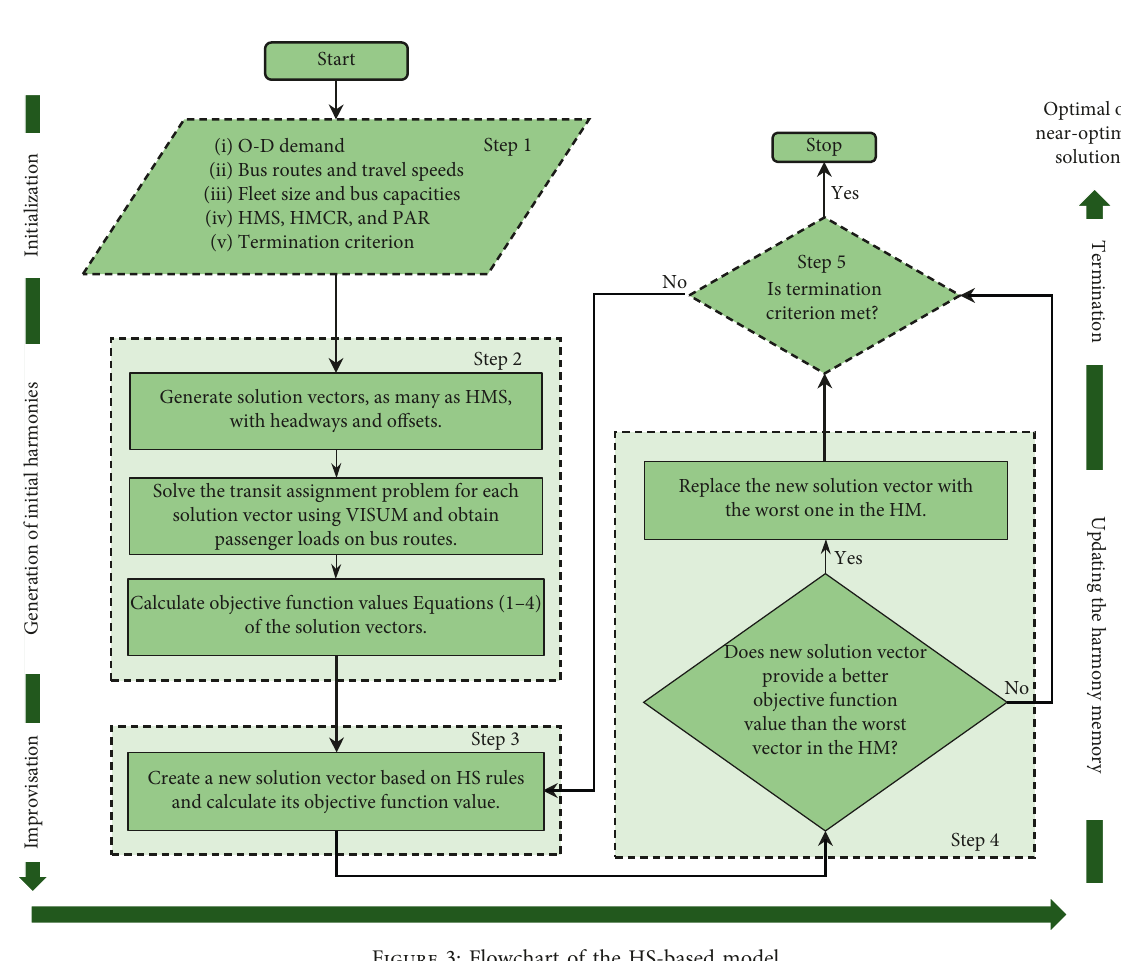
Figure 3: Flowchart of the HS-based